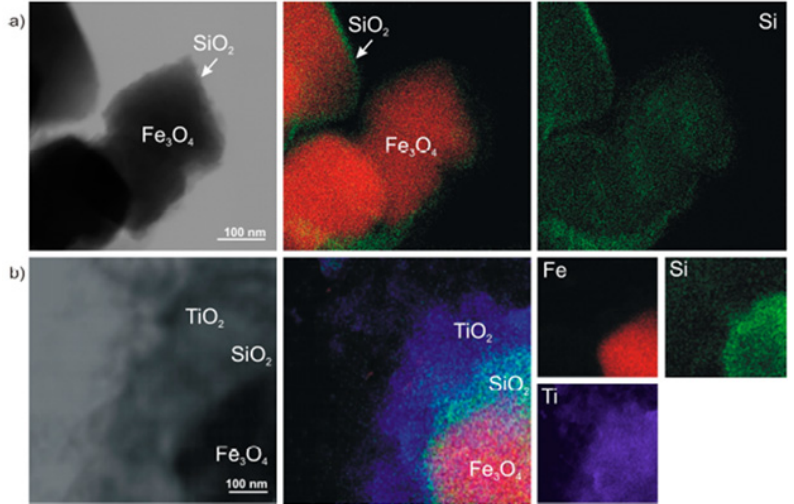
Figure 6. STEM images of Fe 3 O 4 @SiO 2 ( a ) and Fe 3 O 4 @SiO 2 /TiO 2 ( b ) combined with Ti, Fe, and Si mapping. Reprinted with permission from [102]. Copyright (2017) Creative Commons Attribution.